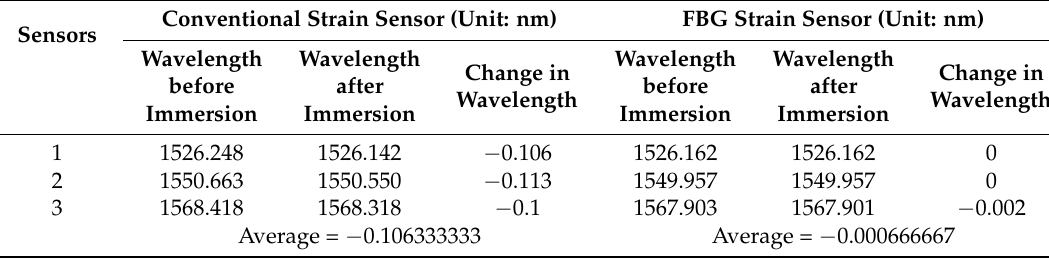
Figure 6. Results of the submergence test of: ( a ) the conventional strain sensors; and ( b ) the FBG strain sensors. Table 4. Results of the submergence